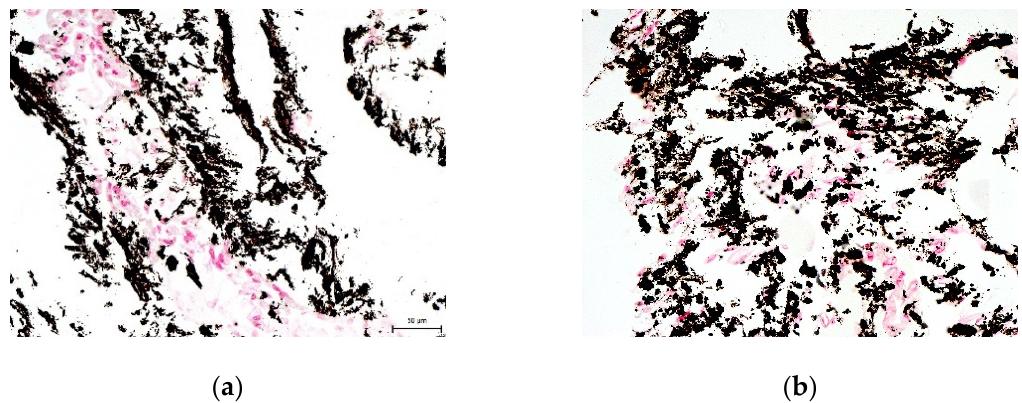
Figure 10. The histological detection of calcium phosphate deposits in the extracellular matrix of paired DPSC lineages after osteogenesis. Deposits are observed as black/brown spots. Scale bar 50 µ m. ( a ) Lineage 5-A; ( b ) Lineage 5-B.